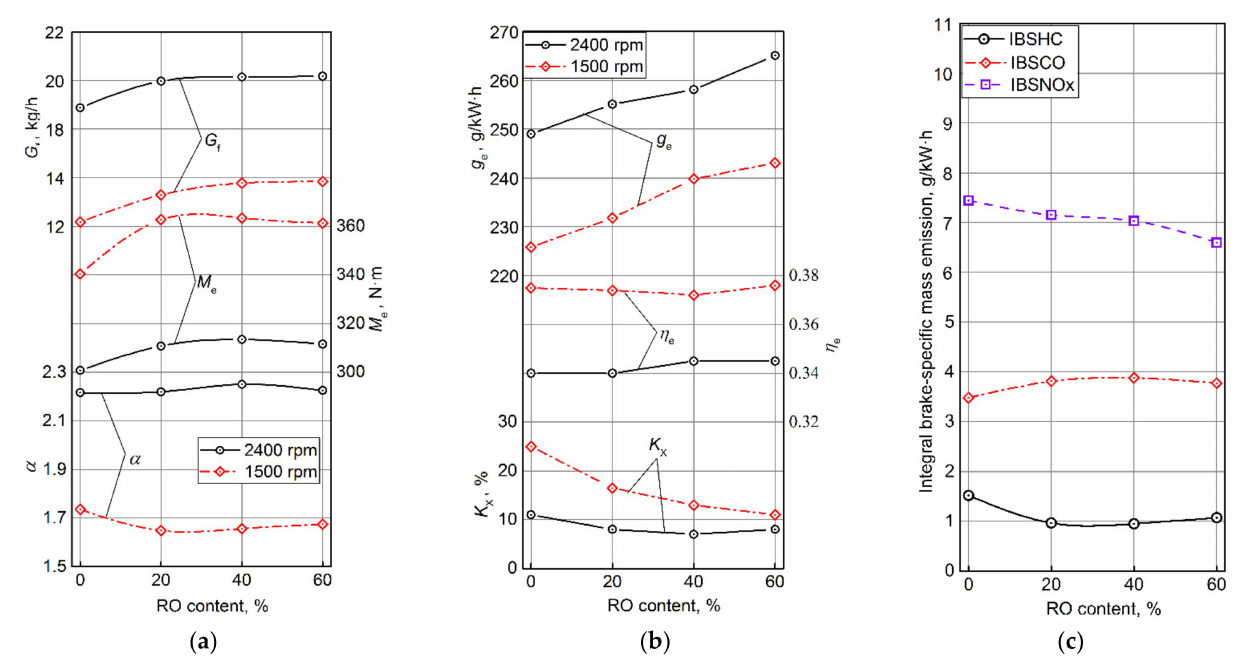
Figure 7. The hourly fuel consumption G f , brake torque M e , excess air ratio α ( a ), BSFC g e , BTE η e and exhaust gas smoke K x ( b ) for the blended biofuels with different RO content in the operating conditions of the external characteristic curve and the integral brake-specific mass emissions of nitrogen oxides (IBSNOx), carbon monoxide (IBSCO), and hydrocarbons (IBSHC) over the 13 modes ( c